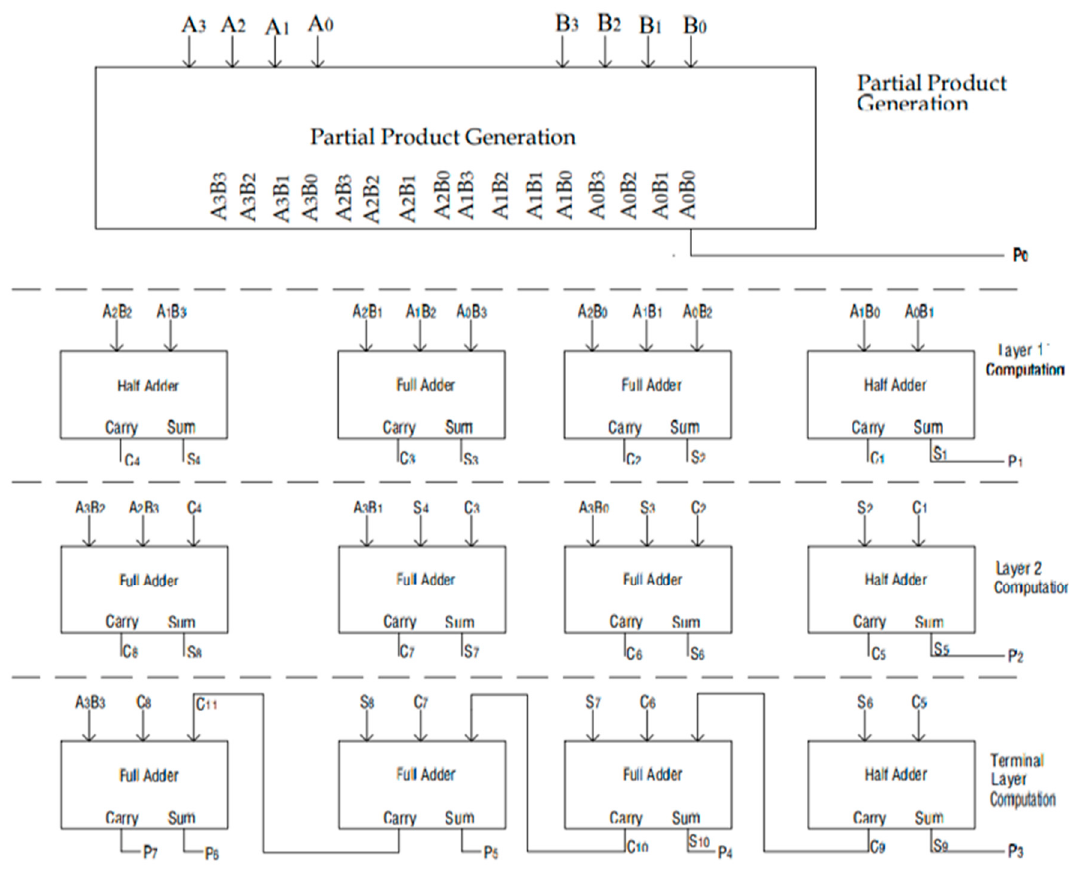
Figure 3. Schematic design of 4 × 4 Wallace multiplier.